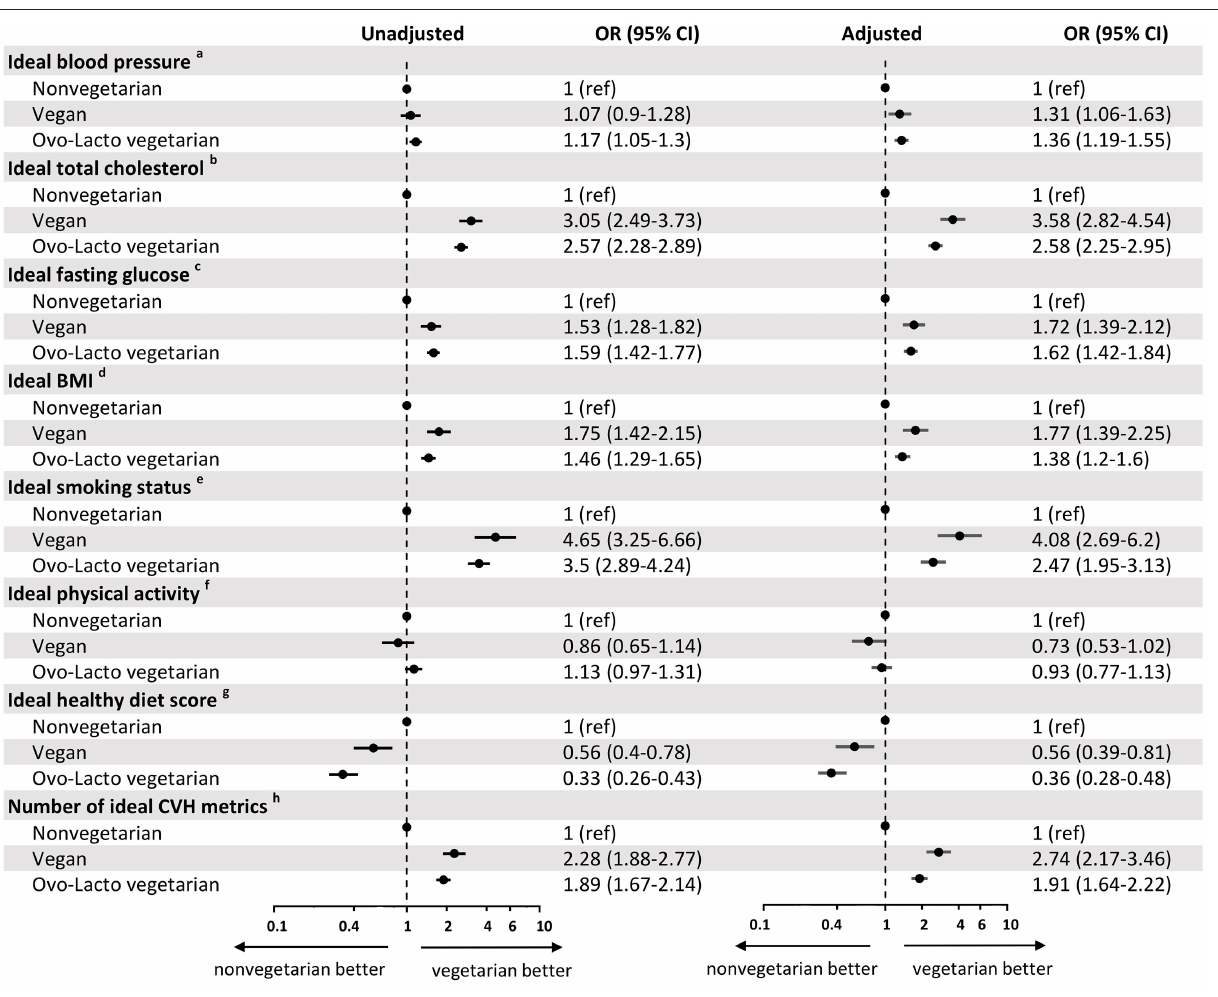
FIGURE 3 | Odds ratio for cardiovascular health metrics associated with non-vegetarian, vegan, and ovo-lacto vegetarian populations. BP, blood pressure; SBP, systolic blood pressure; DBP, diastolic blood pressure; BMI, body mass index. a Ideal blood pressure was defined as SBP < 120 mmHg and DBP < 80 mmHg. b Ideal total cholesterol was defined as total cholesterol < 200 mg/dL. c Ideal fasting glucose was defined as fasting glucose < 100 mg/dL. d Ideal BMI was defined as BMI < 25 kg/m 2 . e Ideal smoking status was defined as never smokers. f Ideal physical activity was defined as physical activity ≥ 210 min/week. g Ideal healthy diet scores was defined as 4-5 components of healthy diet scores. h Number of ideal CVH metrics was defined as 5–7 components of CVH